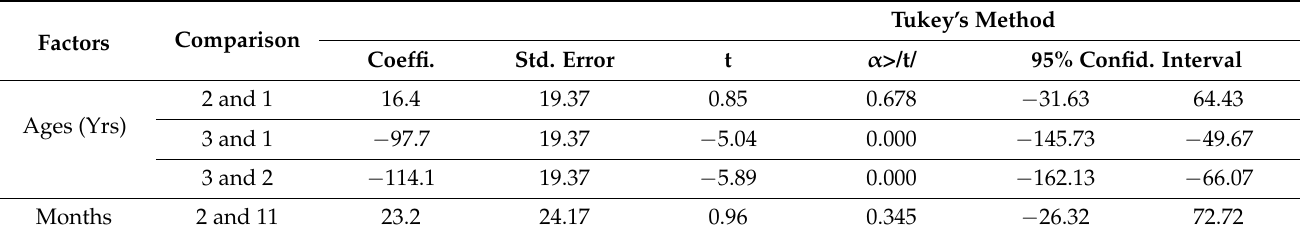
Table 5. Comparisons of tensile strengths for the Mekaneselam bamboo ( Y. alpina ) due to the effects of ages and harvesting